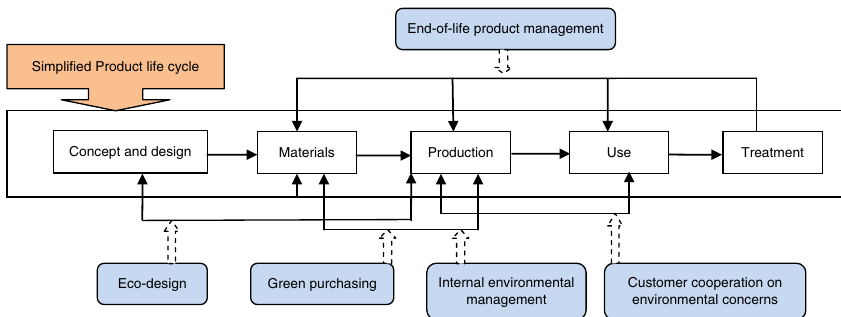
Figure 1. Product life cycle and green supply chain management